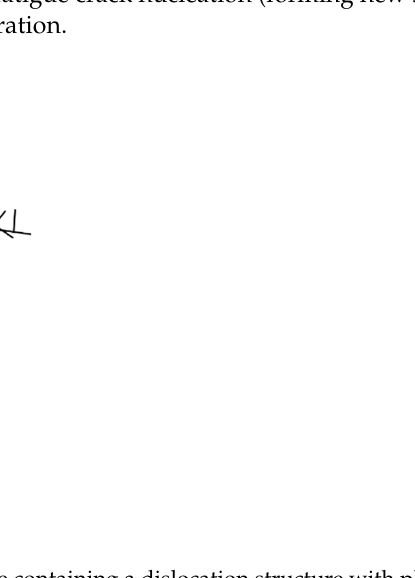
Figure 8. A schematic of microstructure containing a dislocation structure with plastic deformation.